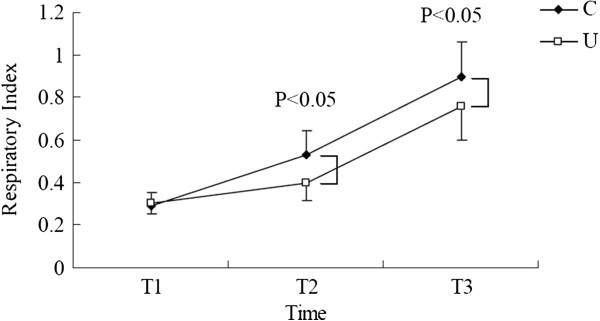
Effect of ulinastatin on respiratory index. Respiratory index (RI) in the ulinastatin group (U) was significantly lower than that in the control group (C) 1 hour after one-lung ventilation (T2) and the time of sternal closure (T3; P < 0.05). The RI was calculated as a marker of lung damage using the following formulas: RI = [FIO2 × (760–47) - PaCO2/0.8]/PaO2.